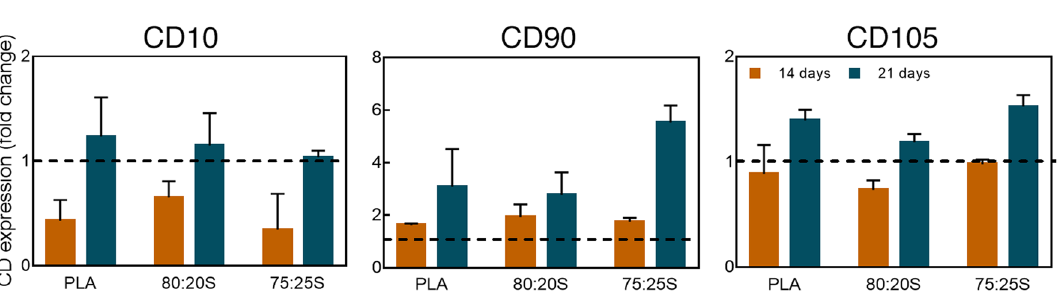
Figure 7. Flow cytometry analysis of CD10, CD105 and CD90 expression in MSC cultured on 3D-printed scaffold for 14 or 21 days under growth conditions. Dashed lines indicate surface marker expression (set to 1) in control cells cultured on tissue culture dishes. Error bars show one standard deviation above the